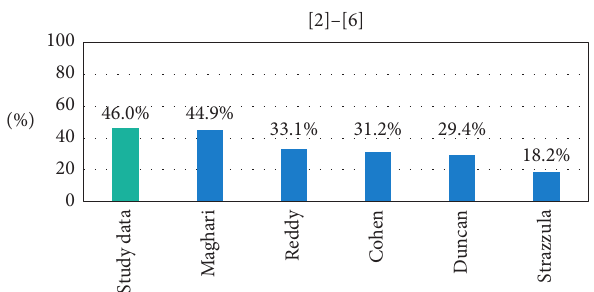
Figure 1: PPV of positive margins in diagnostic biopsies of DN calculated using equation (1) and presented here as a percentage. Six studies, including our own, provide data able to be analyzed to obtain the PPV of positive margins in diagnostic biopsies of DN. In each study, the PPV of positive diagnostic margins is less than 50%.